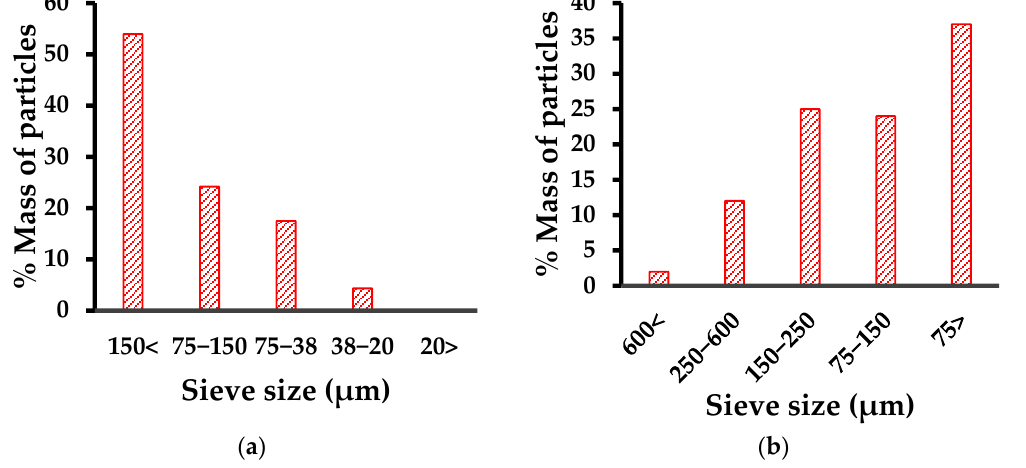
Figure 1. Granulometry for the inorganic phases: ( a ) red mud; ( b ) ferrosilicomanganese fines.